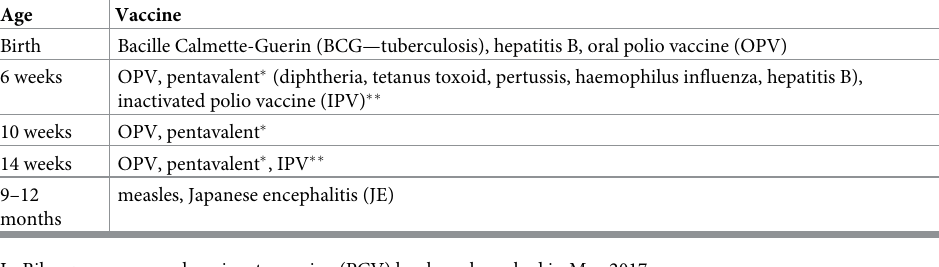
Table 1. National immunization schedule, 2016 state recommendations for